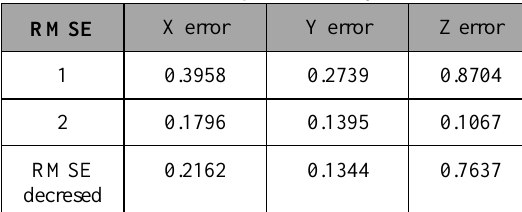
Table 2 RMSE comparison study (unit: